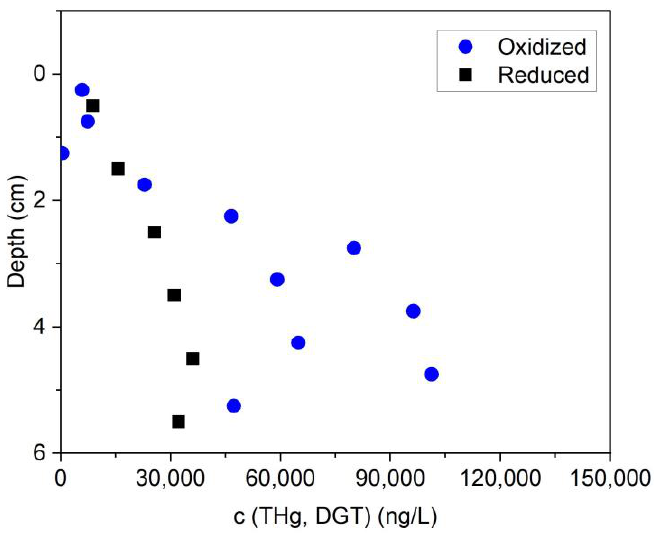
Figure 6. Porewater THg concentration in lab mesocosm using Sediment from South Riverbank RRM 3.5.